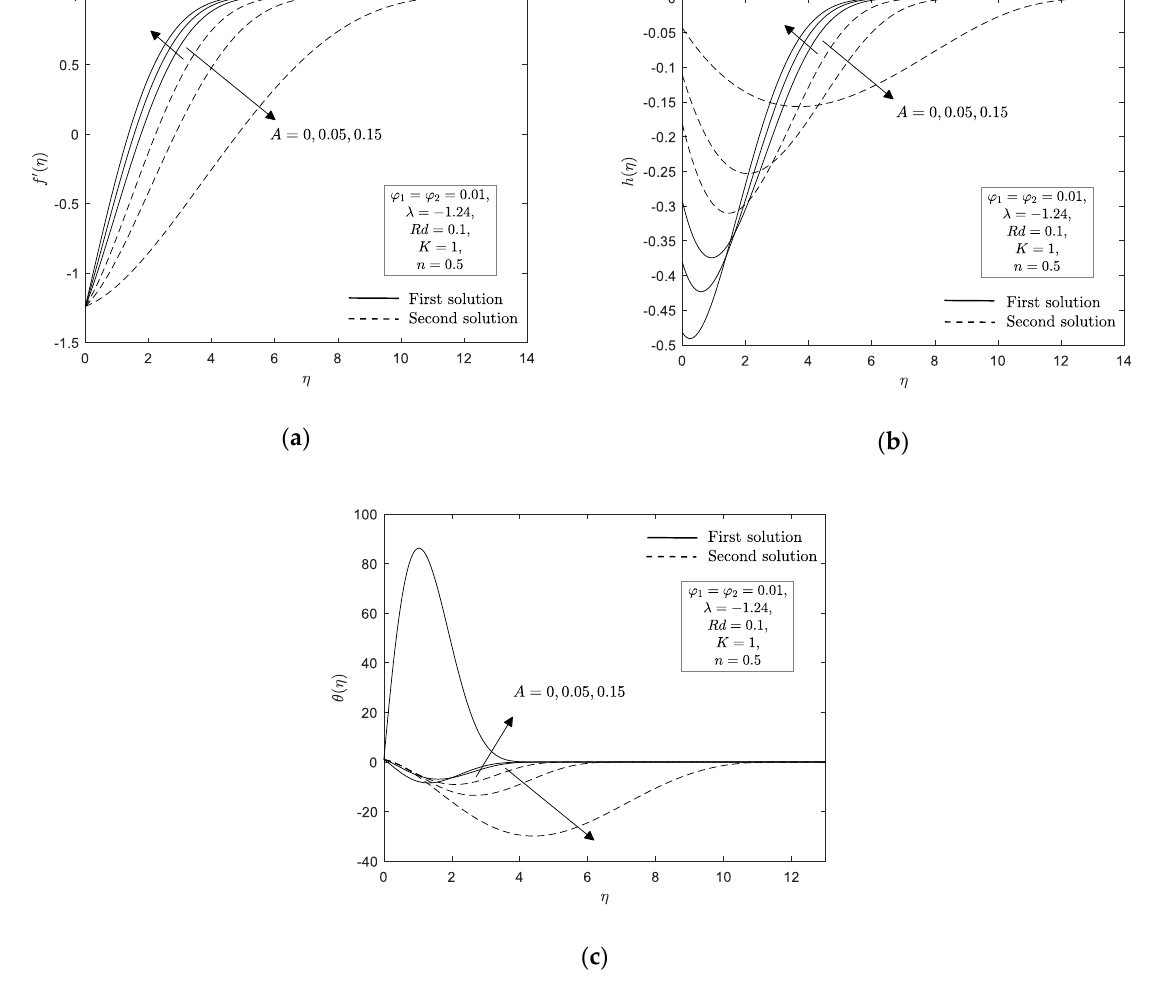
1/2 x ; ( b ) Nu x Re